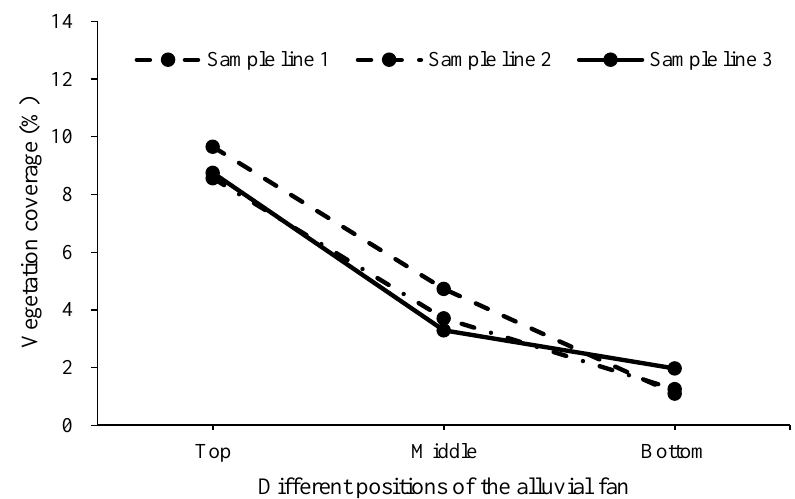
Figure 4. Vegetation coverage of three sample lines at different positions of the alluvial fan. Table 2. The accuracy evaluation of spectral indices extraction.